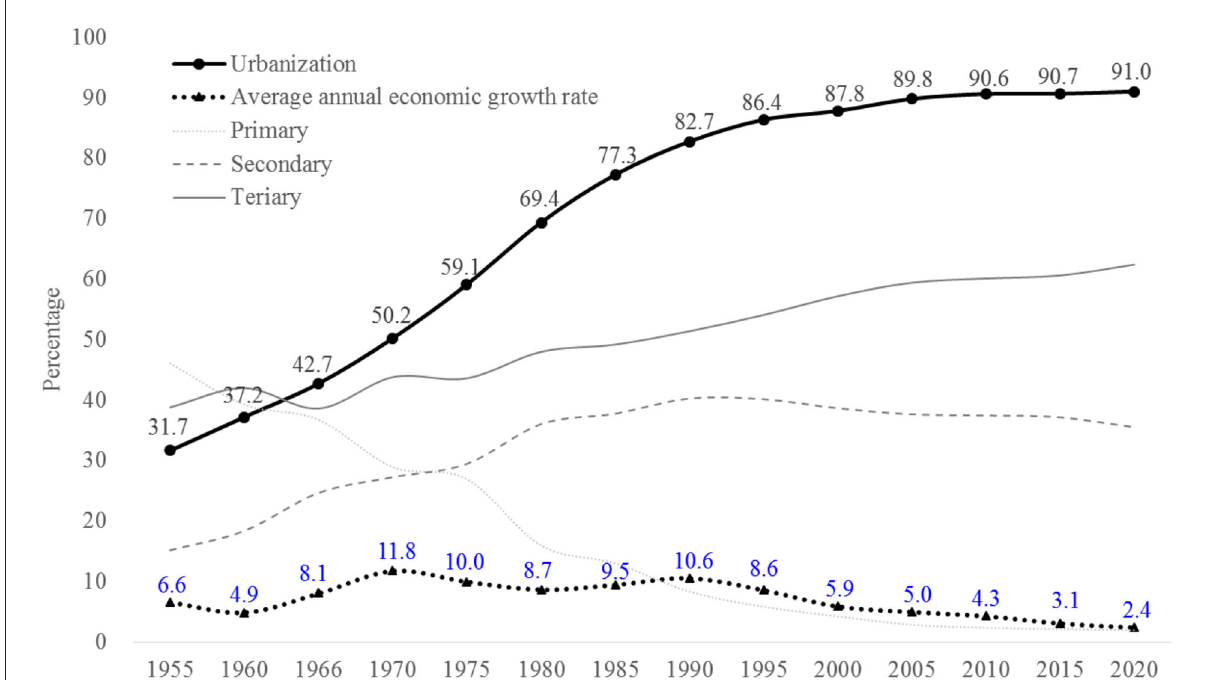
FIGURE1 Average annual economic growth and urbanization rates during 1955–2020. Data sources: Economic Statistics System (https://ecos.bok.or.kr/) and Korean Statistical Information Service (https://kosis.kr/).